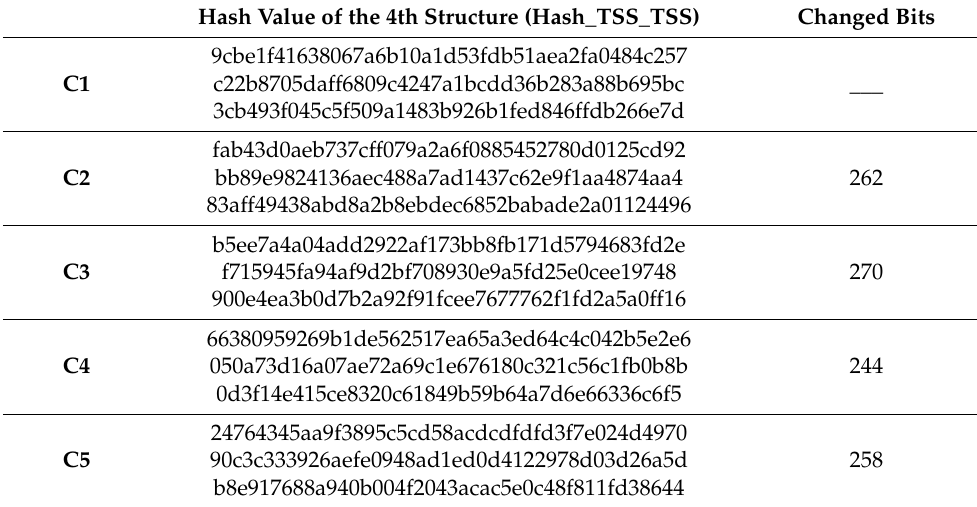
Table 7. Hash values of fourth structure.